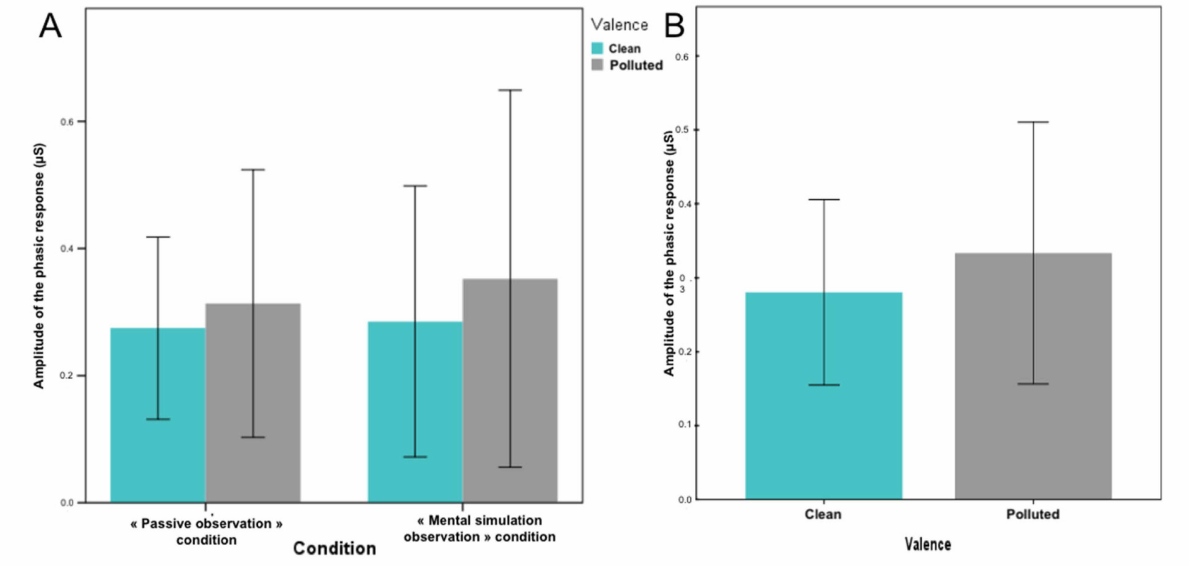
Figure 4. Mean amplitude of the phasic response of electrodermal activity for Clean (blue) and the Polluted (Grey) condition considering the difference between the passive and mental simulation observation conditions ( A ) or averaged on all experimental conditions ( B ).